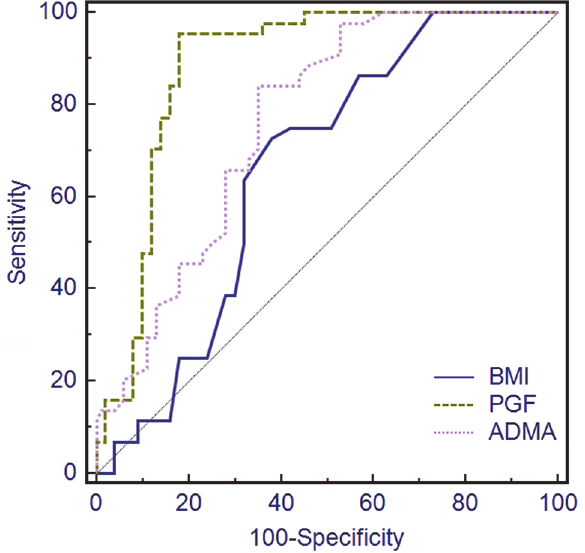
Fig 2. ROC curves of first trimester PGF levels, ADMA levels and BMI in the prediction of preeclampsia.